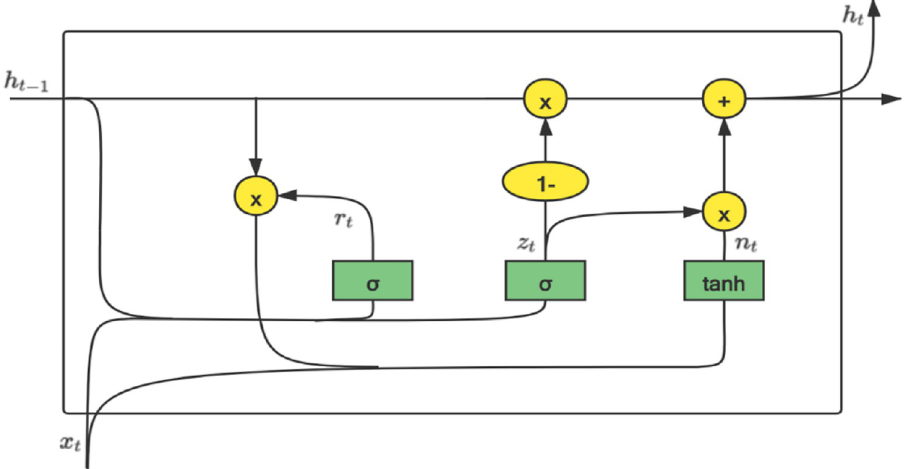
Fig 1. Schematic diagram of the GRU